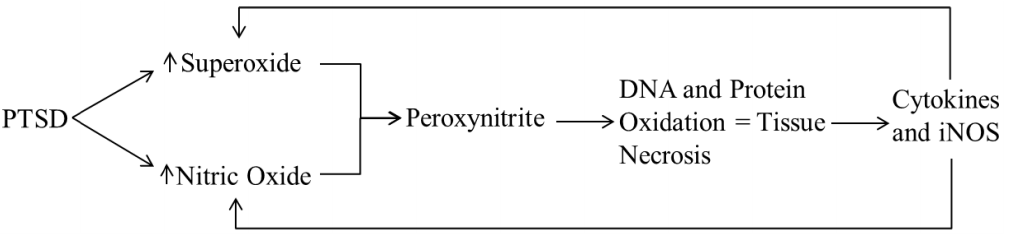
Figure 8. Reactive oxygen species cause tissue damage and necrosis. Cytokine production in PTSD leads to upregulation of superoxide and nitric oxide, which bind to form the very potent oxidizer peroxynitrite. The resulting tissue damage sustains the positive feedback loop causing further detrimental effects.